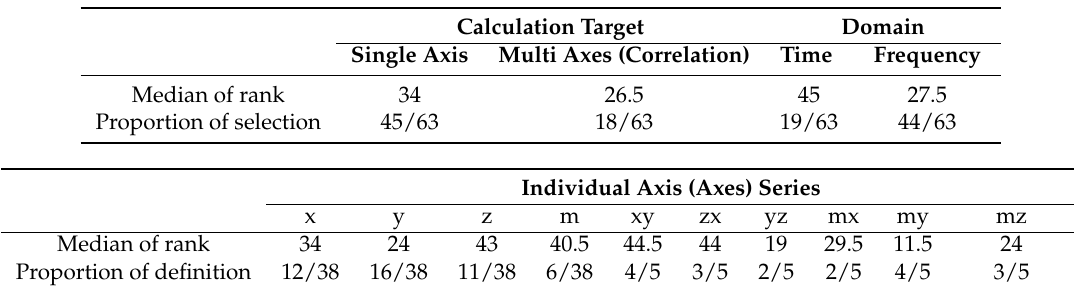
Table 9. Median of the rank and the ratio of selected features for each